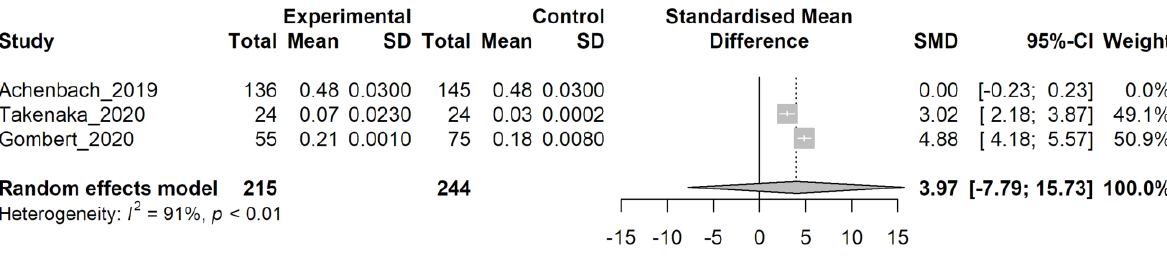
as a graphical diamond on the standardized mean difference graph. Heterogeneity: results from heterogeneity test, I 2 , describes the percentage of variation across studies that is due to heterogeneity rather than chance, p : p - value derived from Cochran’s Q test.